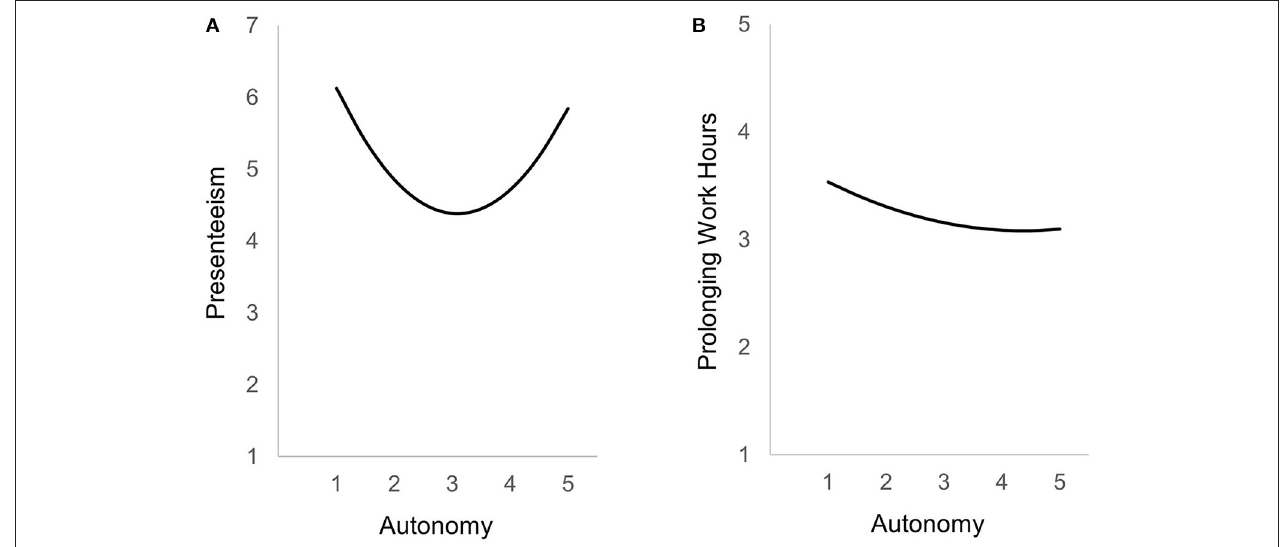
FIGURE 2 | (A) Curvilinear effect of autonomy on presenteeism. (B) Curvilinear effect of autonomy on prolonging of working